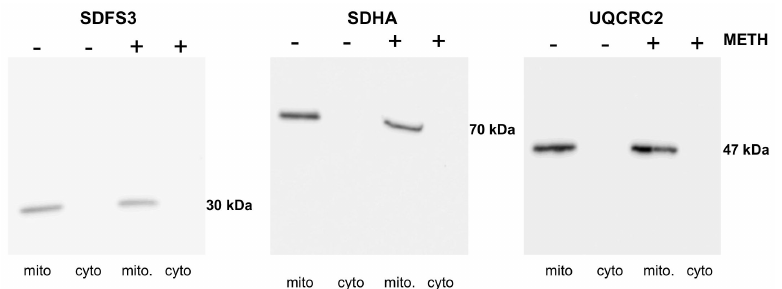
Figure A4. Cytoplasm-suspended mitochondria were incubated for 30 min with 10 µ M metham- phetamine (METH) at 37 ◦ . Mitochondrial and cytoplasmic fractions were subjected to reducing SDS-PAGE. Membranes were probed with anti-NDUFS3, anti-SDHA, or anti-UQCRC2 antibody. Lack of NDFS3, SDHA, or UQCRC2 immunoreactivity in cytoplasmic